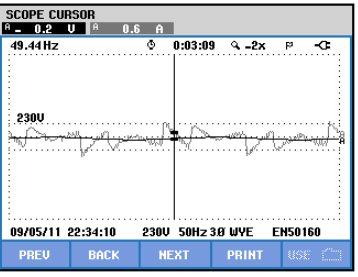
Figure 15. Injected filter current in grid-connected mode.